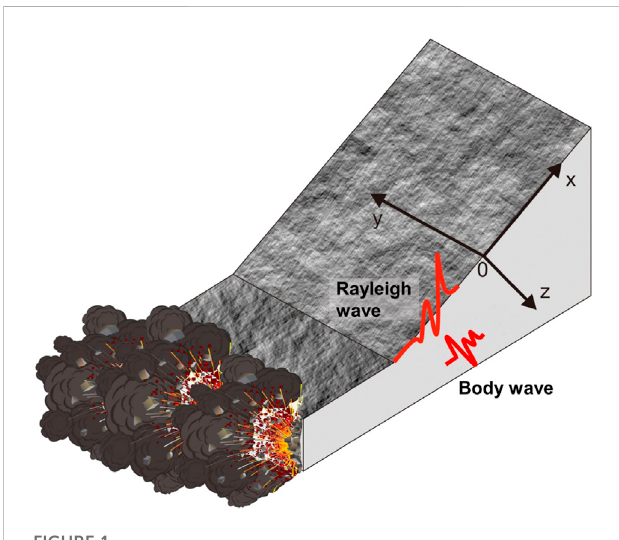
FIGURE 1 Blasting seismic wave in a